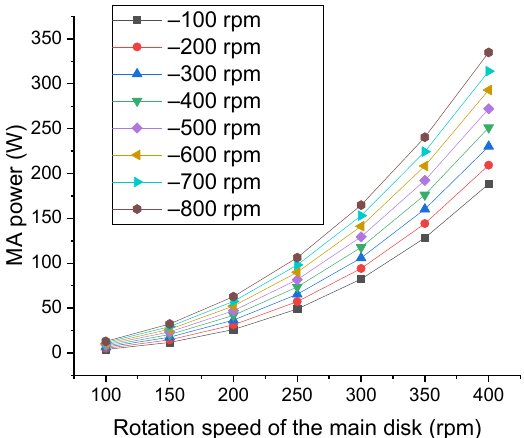
Figure 1. Calculated dependences of MA power on rotation speeds of the main disk and the bowls of Fritsch Pulverisette 4 mill.